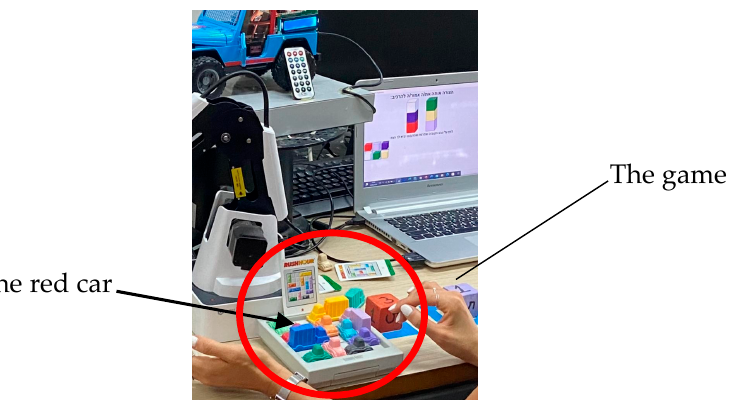
Figure 3. “RUSH HOUR” game.